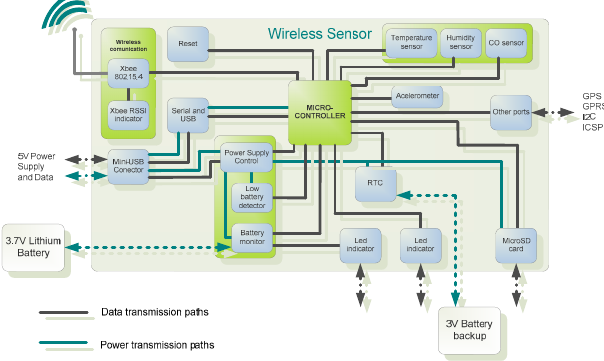
Figure 2. Block diagram with a WSN’s node parts.